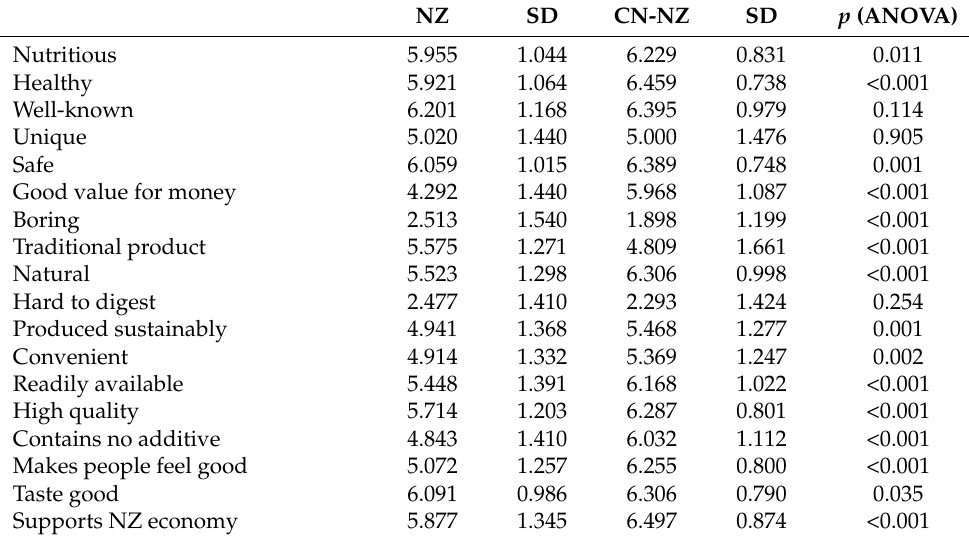
Table 5. New Zealand consumers and Chinese consumers’ opinion of New Zealand lamb (1 = strongly disagree, 7 = strongly agree) (mean ± SD) ( p value determined using ANOVA with ethnicity as main